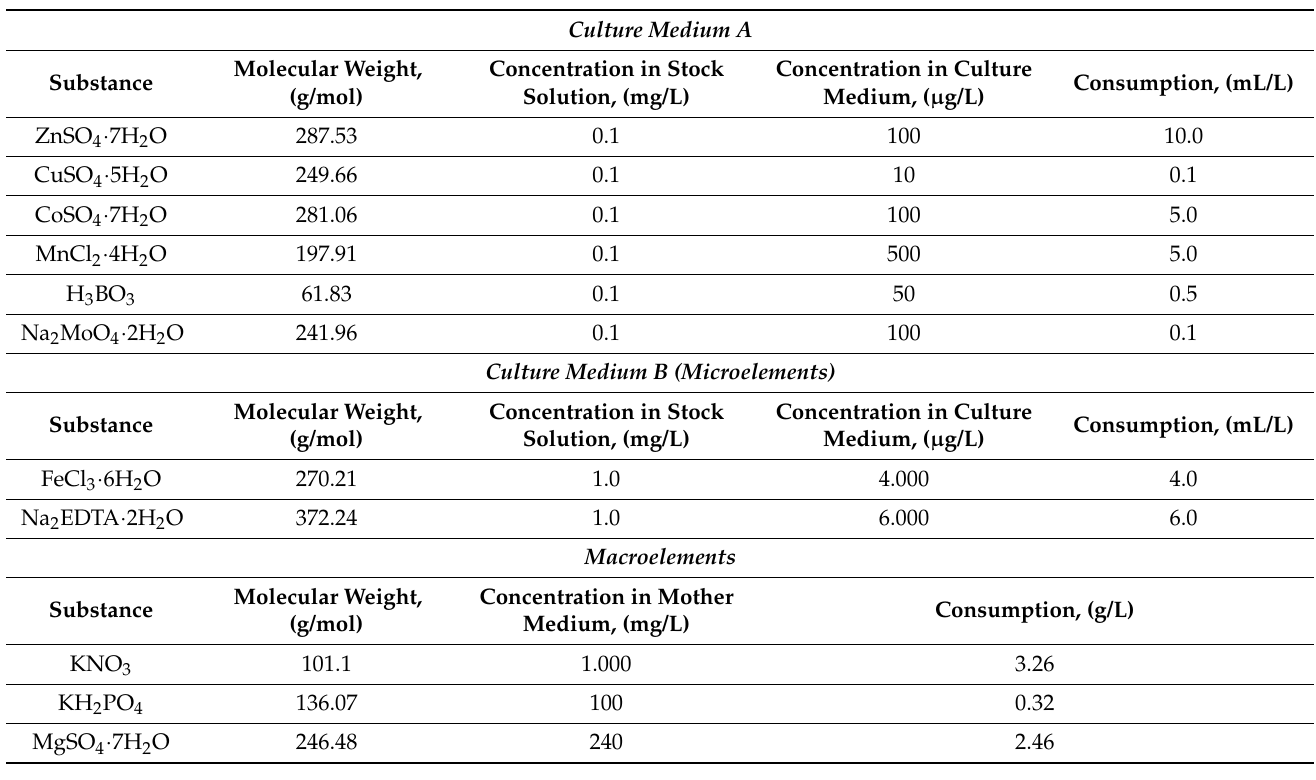
Table 1. Composition of the microalgae culture